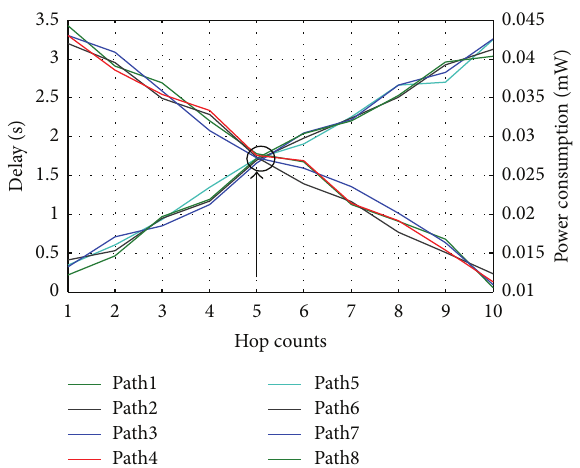
Figure 8: Adopting the objective function with the level cut method for the multipath routing algorithm.